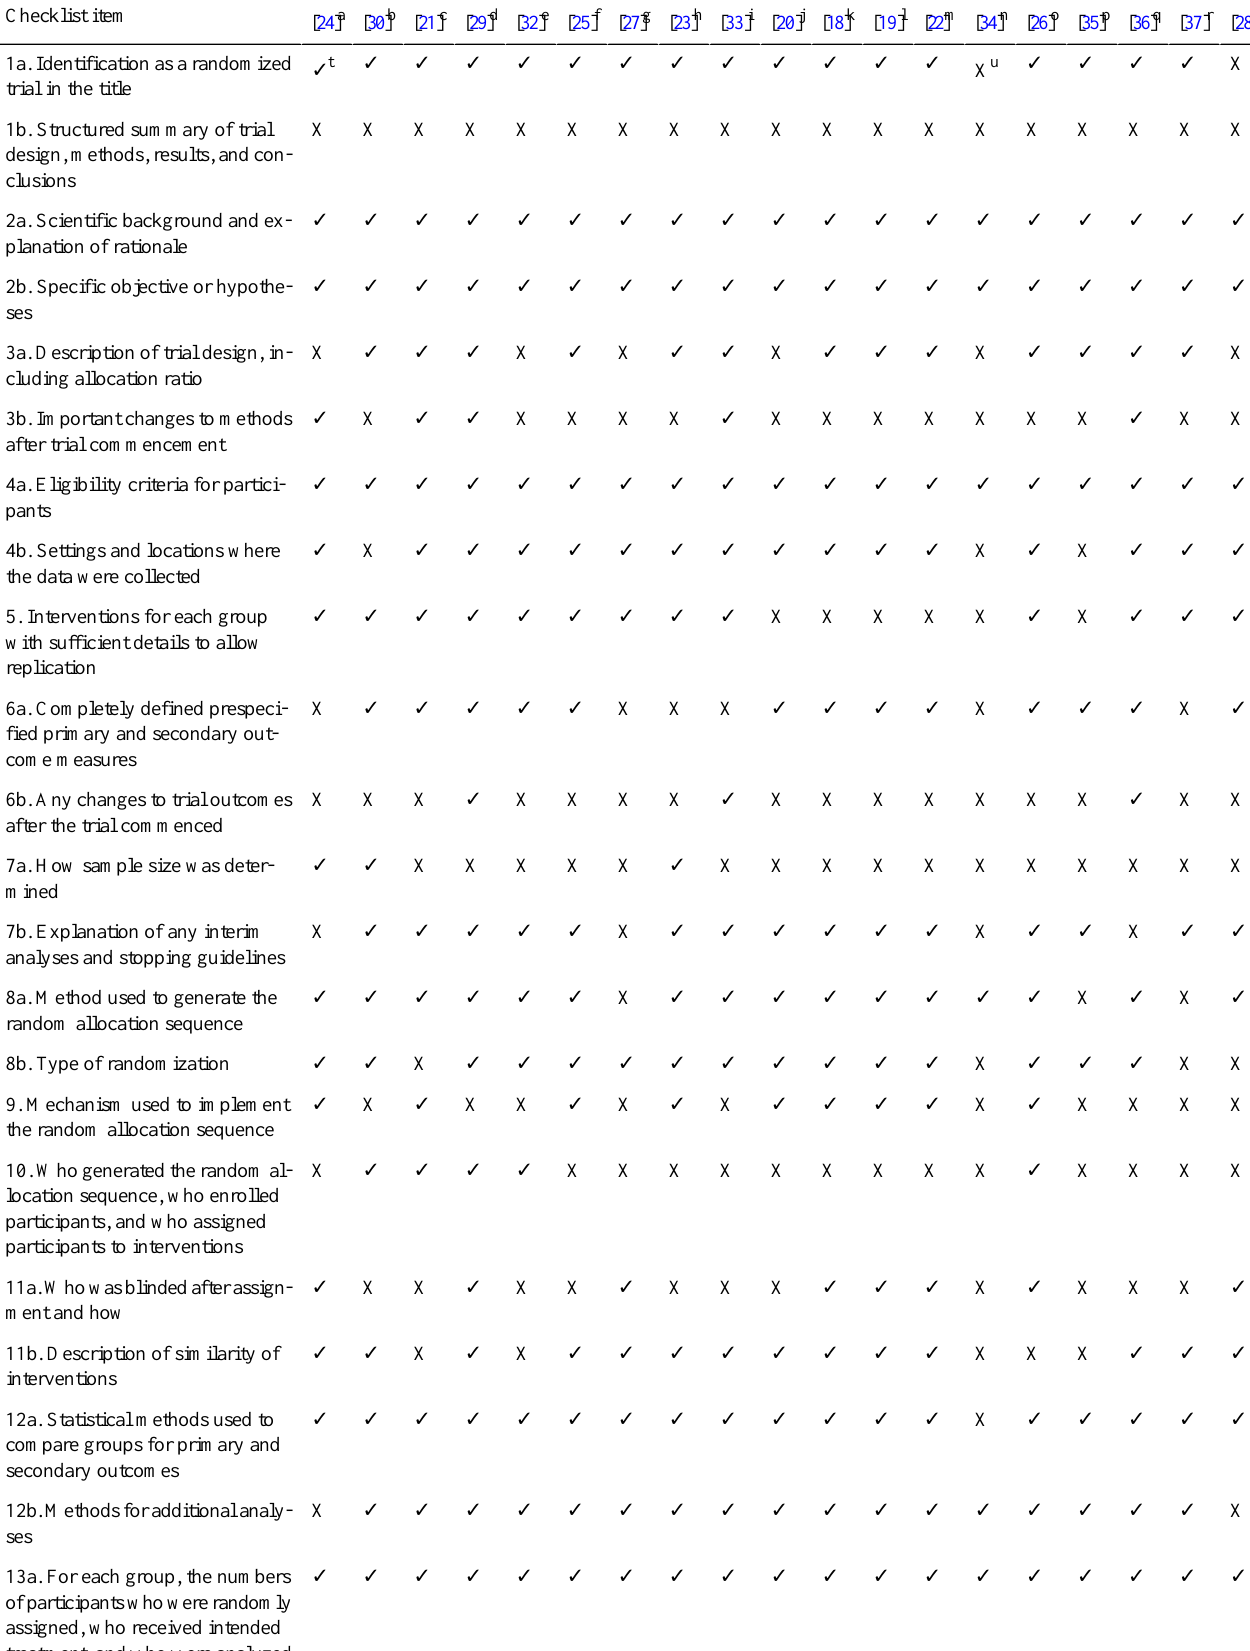
Table 1. Quality of randomized controlled trials. To make them comparative, overall scores are counted (n, %; maximum score 33;